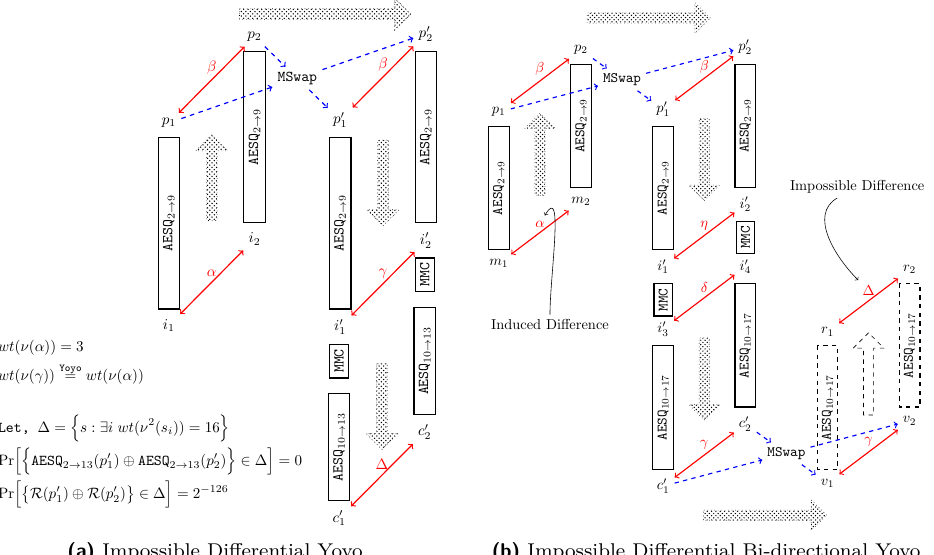
Figure 11: Impossible Differential Yoyo Distinguishers on AESQ